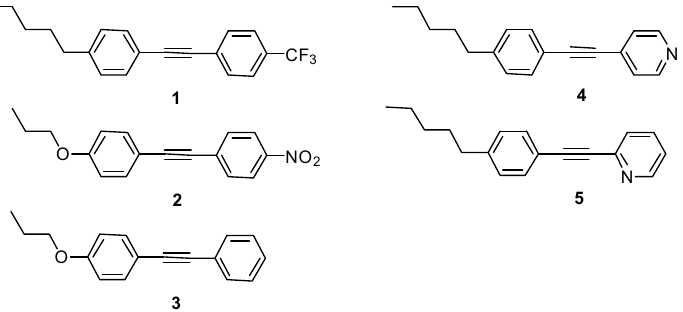
Figure 1. Tolanes ( 1 – 3 ) and N -Hetero-tolane derivatives 4 and 5 .